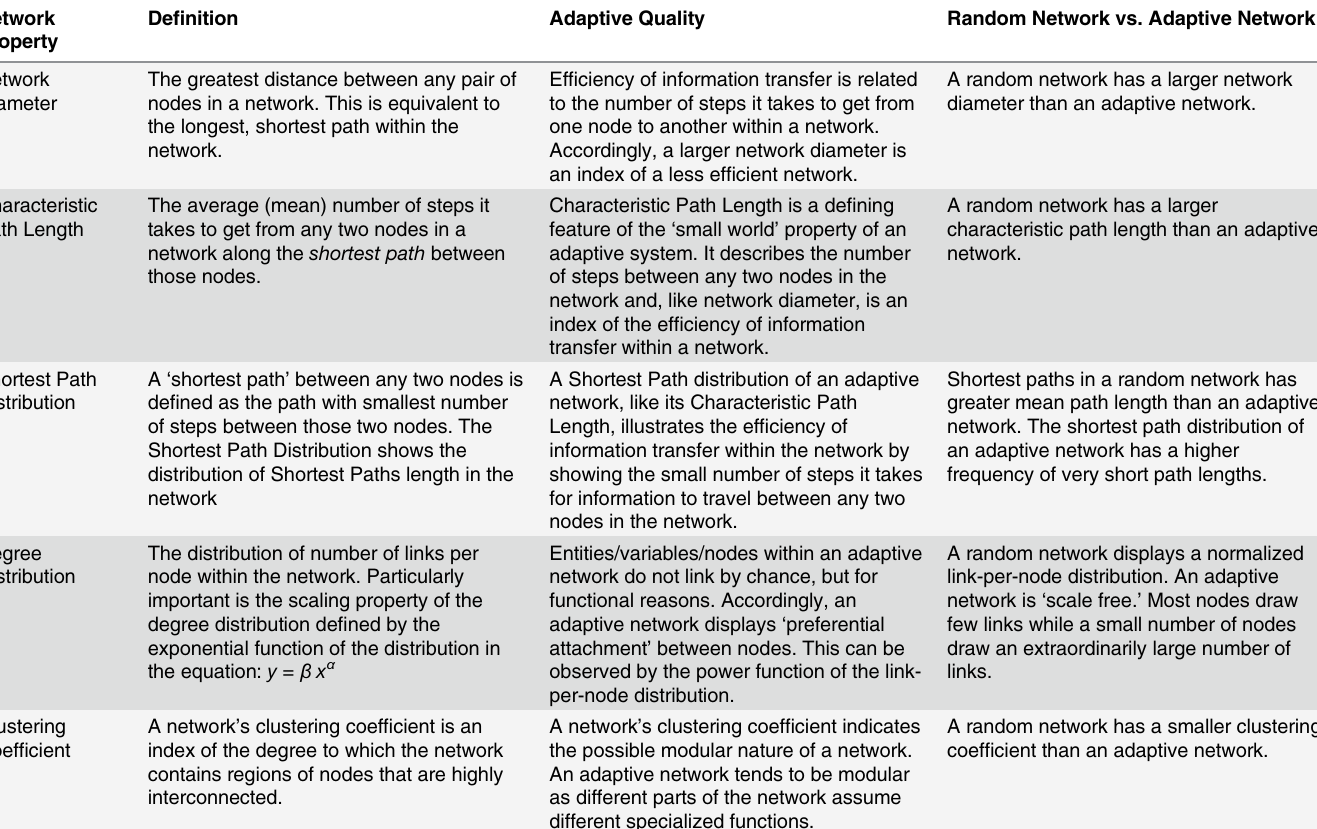
Table 1. Definitions of network properties, their adaptive qualities, and differences between random networks and adaptive networks [15 – 17]. Network De fi nition Adaptive Quality Random Network vs. Adaptive Property